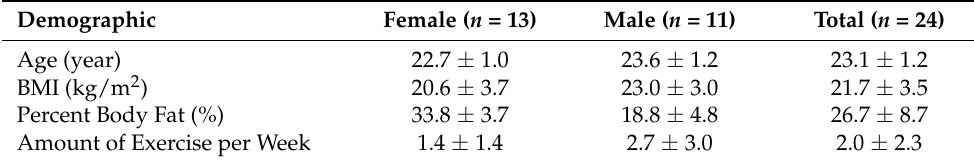
Table 1. Demographic information of participants (Mean ±